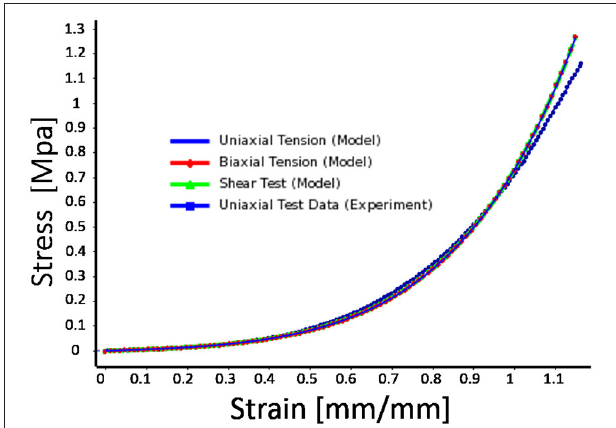
FIGURE 2 | Experimental material characterization results with hyperelastic material model fit (first-order Ogden model). Strain range is greater than maximal principal strains of the actuator ( < 1.0) at maximum applied pressures/vacuum in air